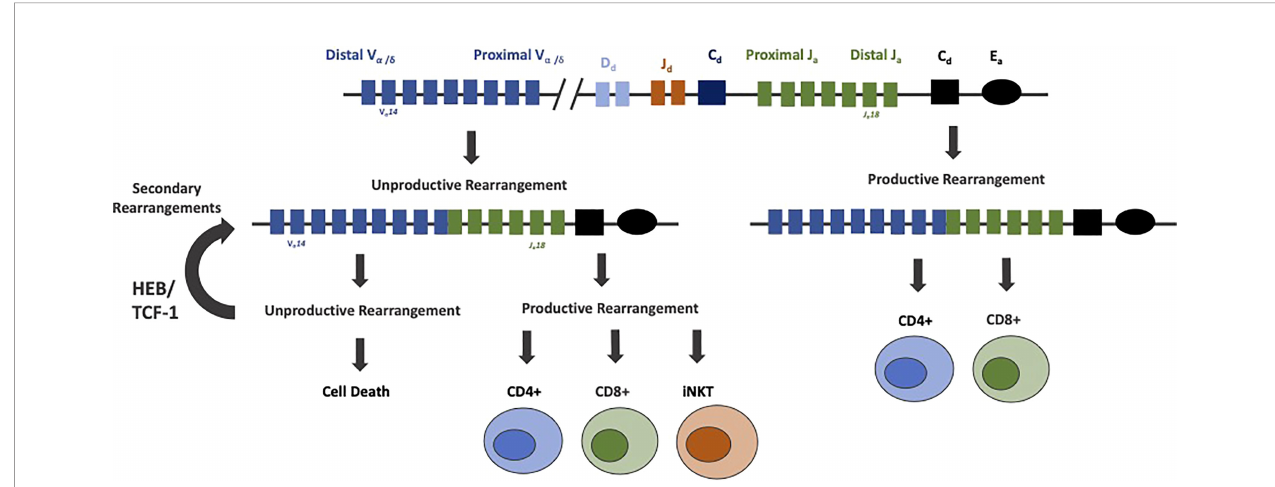
FIGURE 5 | HEB prolongs survival of DP thymocytes and rearrangements of distal V a and J a gene segments. Rearrangement of the TCR a locus proceeds by a deletional mechanism, in which the more proximal gene segments rearrange fi rst. Cells that undergo productive rearrangements that pass positive selection mature into CD4+ and CD8+ mature T cells. Cells with unproductive rearrangements undergo secondary rearrangements, until the cells either produce a productive TCR a allele or undergo cell death. HEB, along with TCF-1, promotes rearrangements of more distal TCR a genes by prolonging cell survival during this process. HEB is crucial for the rearrangement of distal TCR a genes, production of a diverse ab T cell repertoire, and generation of iNKT cells expressing an invariant TCR a protein composed of the distally located V a 14 and J a 18